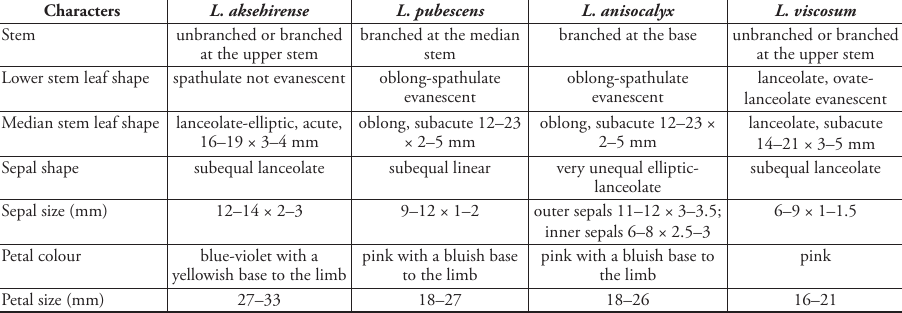
Table 1. Morphological comparison of Linum aksehirense , L. pubescens , L. anisocalyx and L. viscosum .